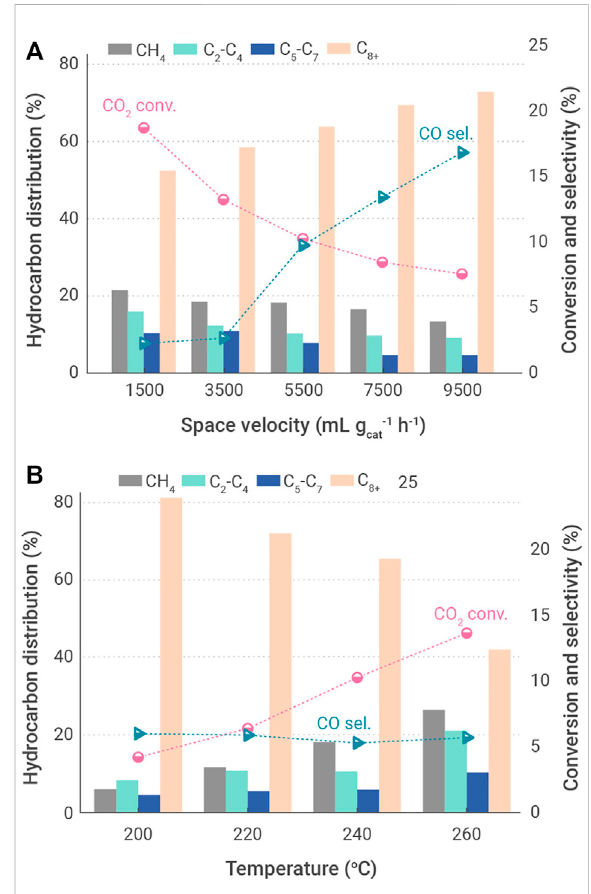
FIGURE 6 Effects of operation conditions on catalyst performance for the hydrogenation of CO 2 into jet fuel range hydrocarbons over CoFe-0.81Na catalyst (Zhang et al., 2021). (A) Different reaction temperatures. (B) Different space